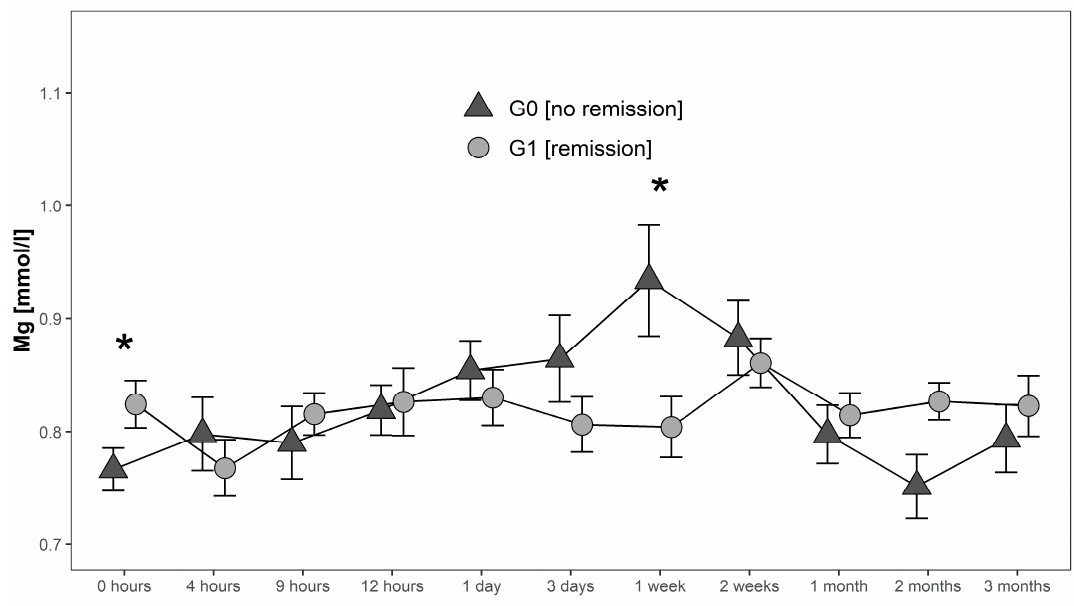
Figure 4. Mean Mg serum level comparison, presenting and comparing patients with (G1) and without (G0) neurological remission. Expressed as mean values ± standard error of the mean. The Mann-Whitney-U-Test assessed significant differences between both groups at each time-point (* p < 0.05).